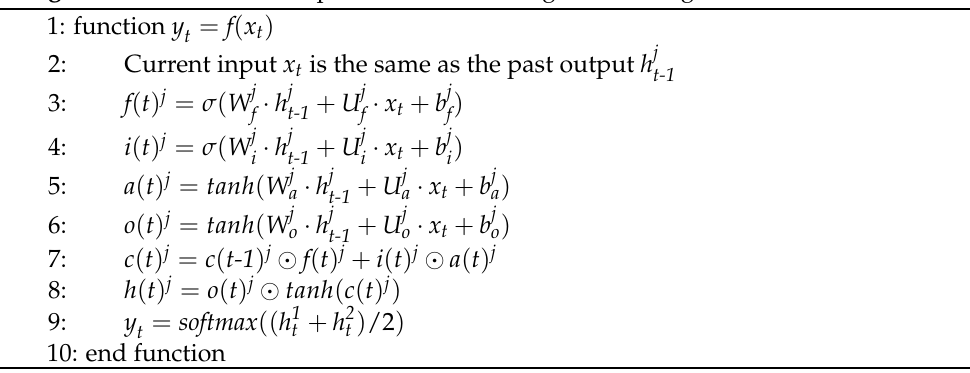
Algorithm 1: Bi-LSTM temporal feature learning network algorithm.